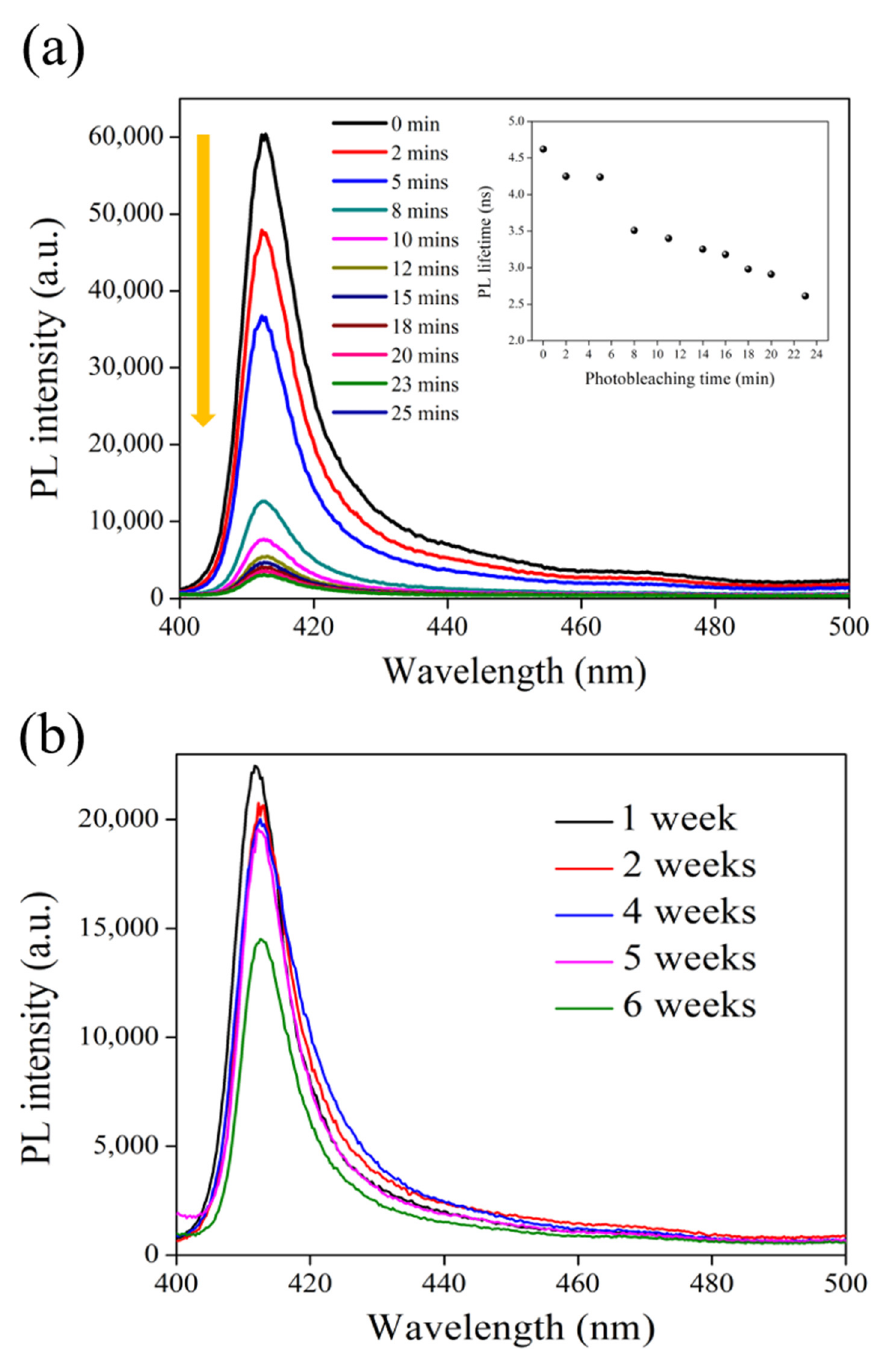
Figure 8. ( a ) Photobleaching behavior and PL lifetime (inset) of 2D perovskite under continuous 380 nm picosecond laser light exposure. ( b ) Long-term PL stability of 2D perovskite stored in an open environment and at room temperature.